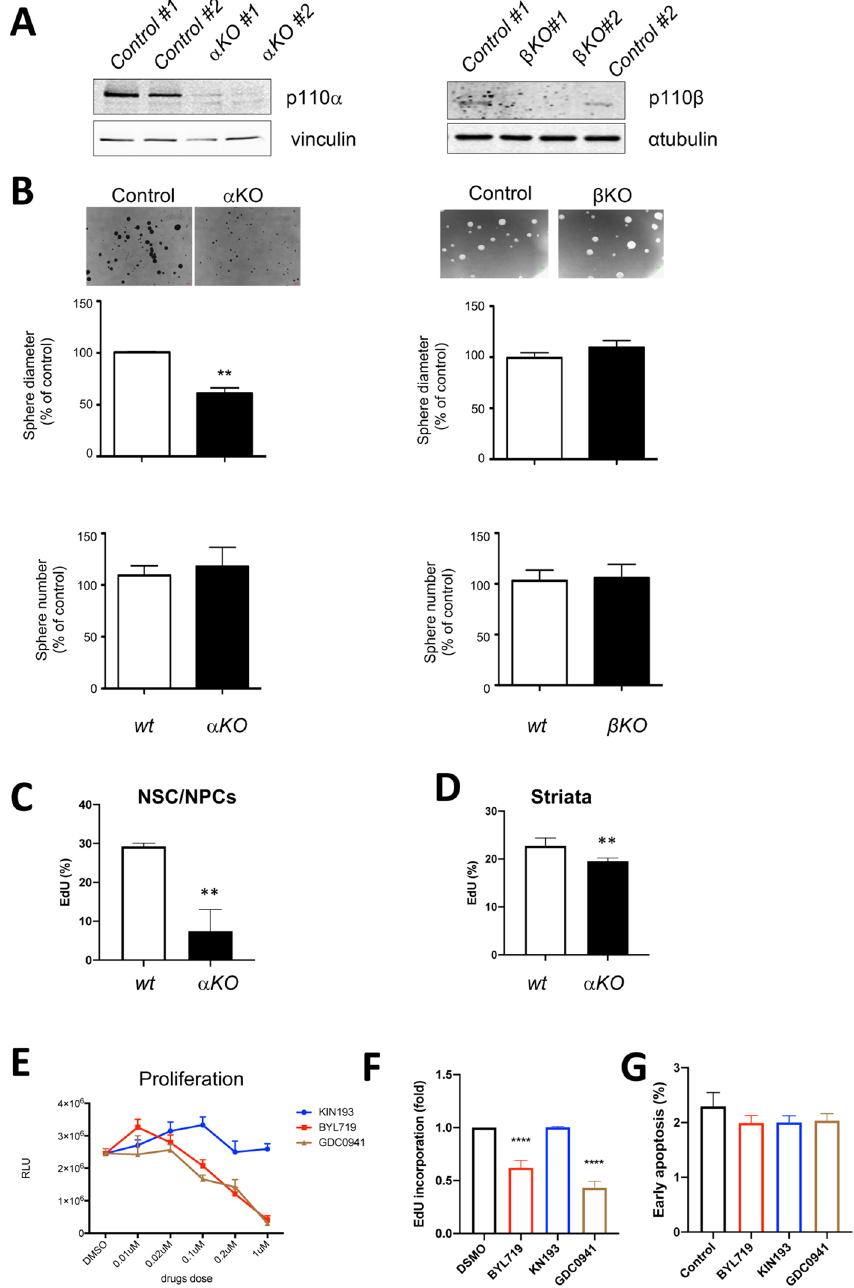
Figure 4. Ablation of p110α, but not p110β, reduces the neurosphere proliferation using primary cultured neural stem/progenitor cells (NSC/NPCs). ( A ) Immunoblotting of p110 expression in embryonic NSC/ NPCs isolated from wild type ( Pi3kca f/f , Control ) and αKO ( GFAP + ; Pi3kca f/f ) littermates (left panel); or wild type ( Pi3kcb f/f , Control ) and βKO ( GFAP + ; Pi3kcb f/f ) littermates (right panel). ( B ) Representative image of neurospheres cultured for 7 days (top panel). Quantification of neurosphere size (middle panel) and neurosphere number (bottom panel). Data represents mean ± SEM (n = 4–6). ** P < 0.01. ( C ) EdU incorporation in NSC/NPCs. Cells were labedled with EdU (10 μM) for 60 min. Data represents mean ± SD (n = 3). ** P < 0.01. ( D ) EdU incorporation in striata cells. Pregnancy mice were injected with EdU (5 mg/ml, 300 μl) and euthanized 4 h later to collect E14.5 embryonic striata and EdU + cells were determined by flow cytometry. Data represents mean ± SD (n wt = 3, n αKO = 7). ** P < 0.01. ( E ) Cell viability of wild type NSC/NPCs treated with BYL719 (a p110α inhibitor), KIN193 (a p110β inhibitor), or GDC0941 (a pan p110 inhibitor) for 3 days. Proliferation were accessed by CelltiterGlo. Data represents mean ± SEM (n = 3). ( F ) EdU incorporation in wild type NSC/NPCs treated with indicated compounds (1 μM) for 3 days. Cells were labelled with EdU (10 μM) for 90 min. Data represents mean ± SEM (n = 6). **** P < 0.0001. ( G ) Early Apoptosis of NSC/NPCs with the indicated compounds (1 μM) treatment for 3 days measured by Annexin V+/PI− staining and flow cytometry. Data represents mean ± SD (n =